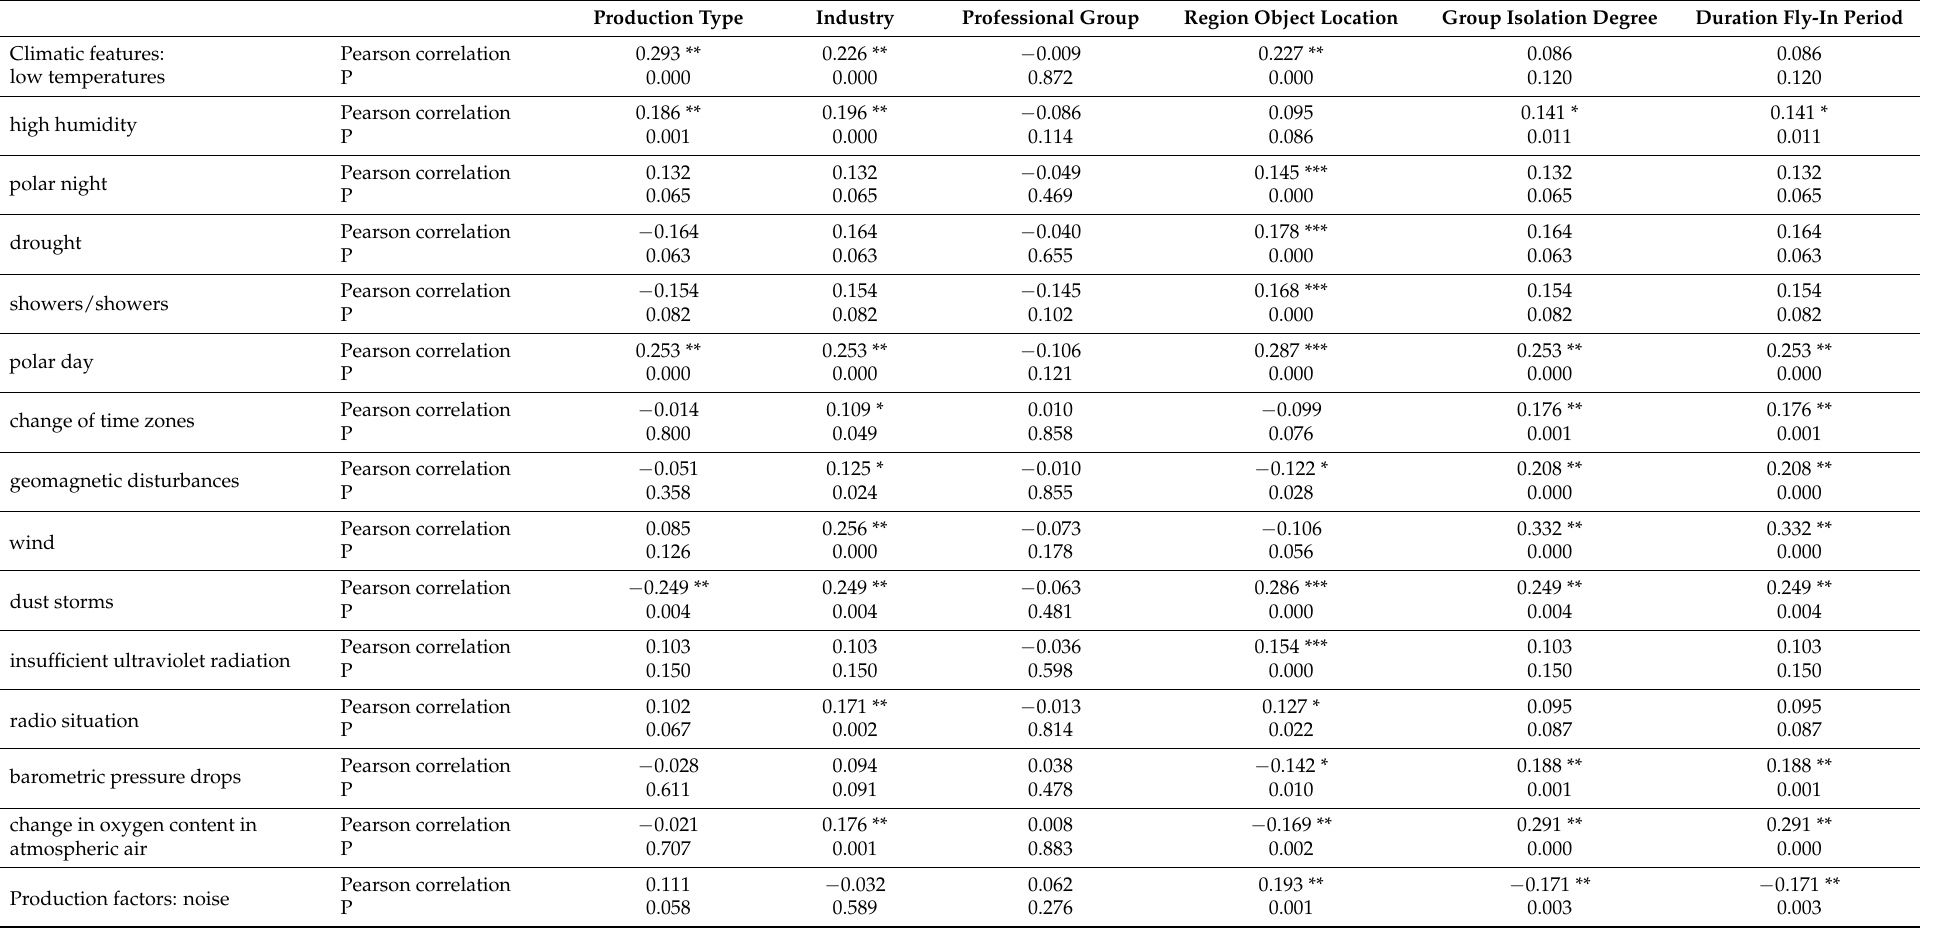
Table A1. The value of the correlation coefficients and the p -level of significance of the relationship between the subjective assessment of the discomfort of climate and geographic, production and social factors and groups of different levels of differential analysis of the professional activity of FIFO